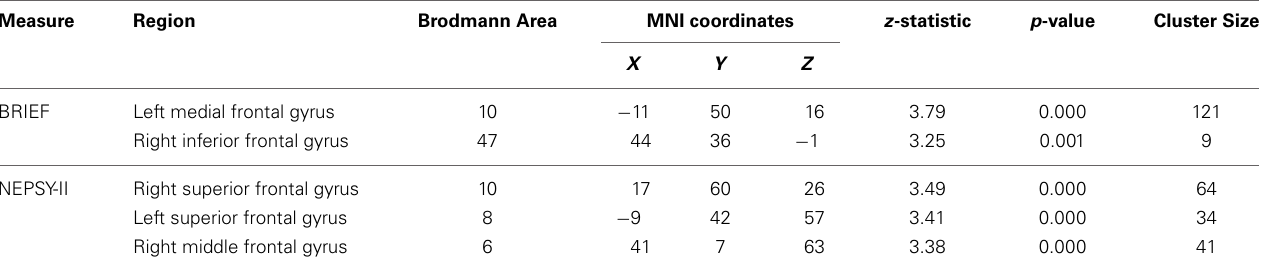
Table 6 | Regions showing post-intervention gray matter volume increases that were correlated with behavioral improvements in TX group.